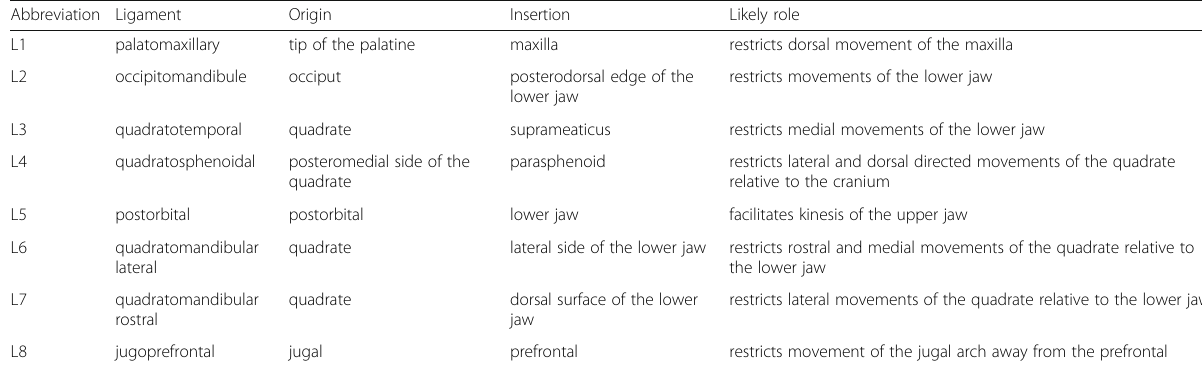
Table 3 The skull ligaments of columbiform birds [34] (van Gennip 1986)